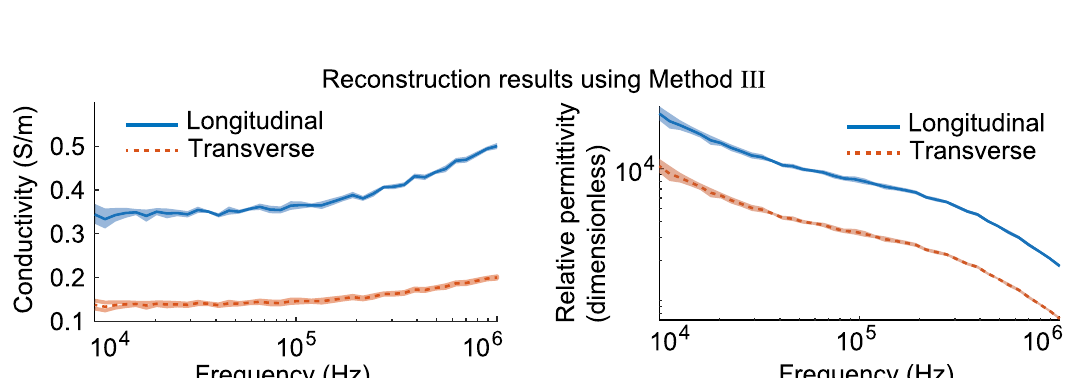
3 times the standard deviation ±